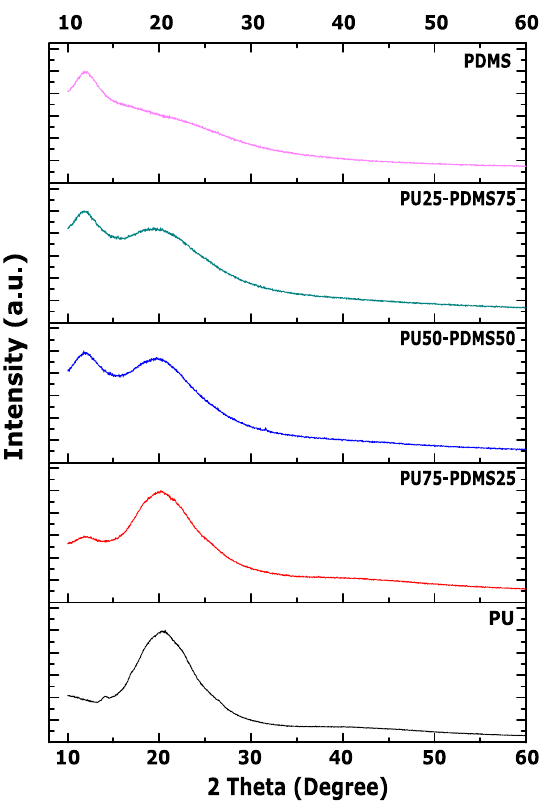
Figure 3: The XRD results of PU – PDMS polymer coatings.